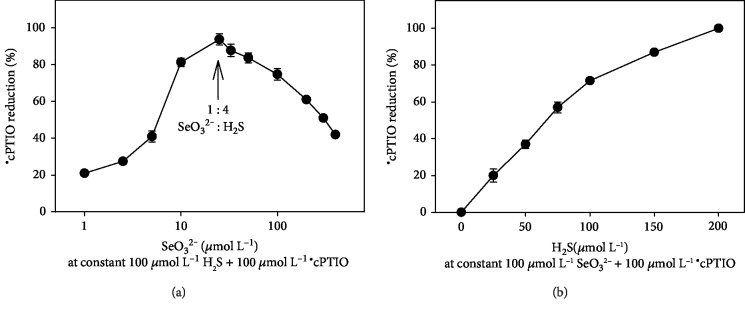
Effect of the SeO32− and H2S concentration on the reduction of ·cPTIO. (a) Effect of the SeO32− concentration (1-400 μmol L−1) on the reduction of ·cPTIO (100 μmol L−1) in the presence of H2S (100 μmol L−1). Arrow indicates the 1 : 4 molar ratio of SeO32− : H2S. (b) Effect of the H2S concentration (0-200 μmol L−1) on the reduction of ·cPTIO (100 μmol L−1) in the presence of SeO32− (100 μmol L−1). The reduction of ·cPTIO was evaluated as the decrease of the absorbance at 560 nm after 2.25 min of the reaction (pH 7.4, 37°C). All values represent the means ± S.E.M., n = 2‐4.